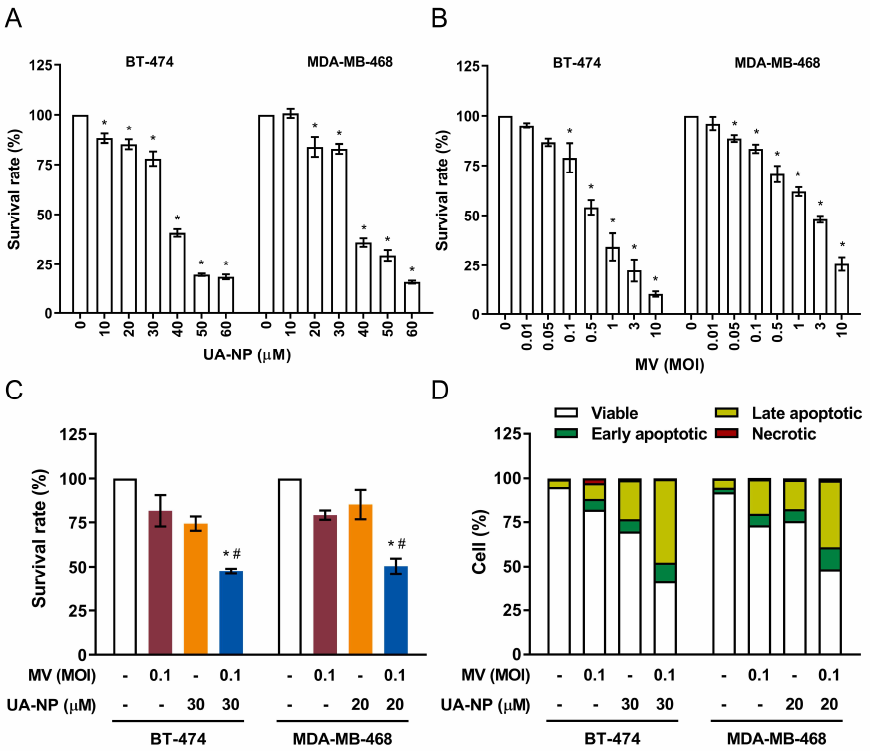
Figure 8 Figure 8. Combination treatment using UA-NP and oncolytic MV exerts enhanced anticancer effect against human breast cancer BT-474 and MDA-MB-468 cells. BT-474 and MDA-MB-468 cells were treated with ( A ) UA-NP (10–60 µ M) or ( B ) MV (MOI 0.01–10) for 5 days before analysis of cell viability using MTT assay. DMSO = 0.1%. ( C ) BT-474 and MDA-MB-468 cells were co-treated MV (MOI 0.1) and/or UA-NP (30 µ M for BT-474 and 20 µ M for MDA-MB-468), following which cell viability was determined by MTT assay. ( D ) BT-474 and MDA-MB-468 cells were first concurrently treated with UA-NP (30 or 20 µ M) and MV (MOI 0.1) for 5 days, and then analyzed by flow cytometry for apoptosis induction. Data shown are means ± SEM from three independent experiments; * p < 0.05 in ( A , B ); * p < 0.05 compared with MV MOI 0.01 or 0.1, # p < 0.05 compared with UA treatment only in ( C